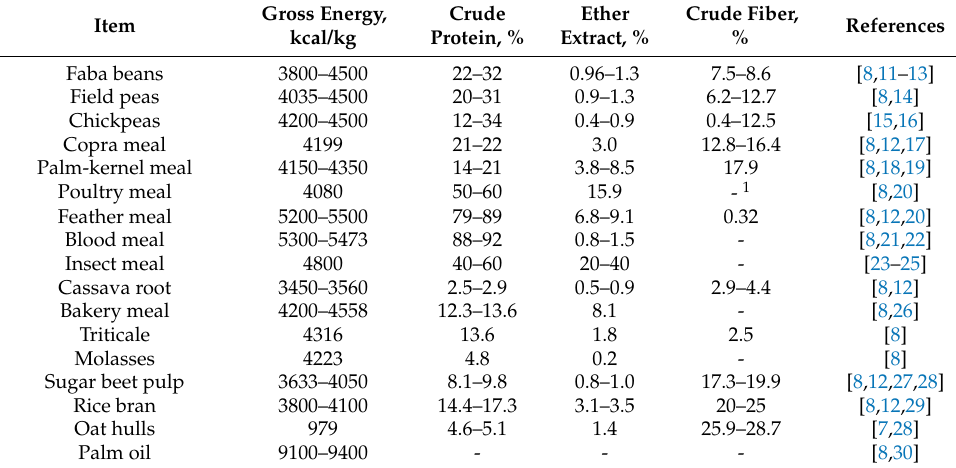
Table 1. Nutrient composition of some atypical feed ingredients for broiler chickens and